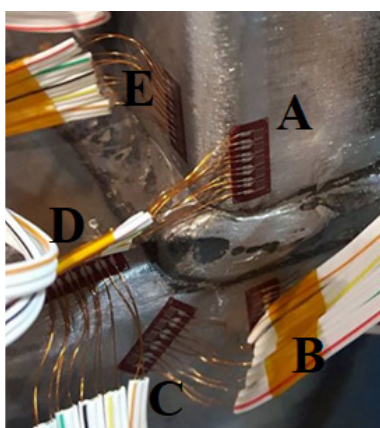
Figure 2. Hot spot